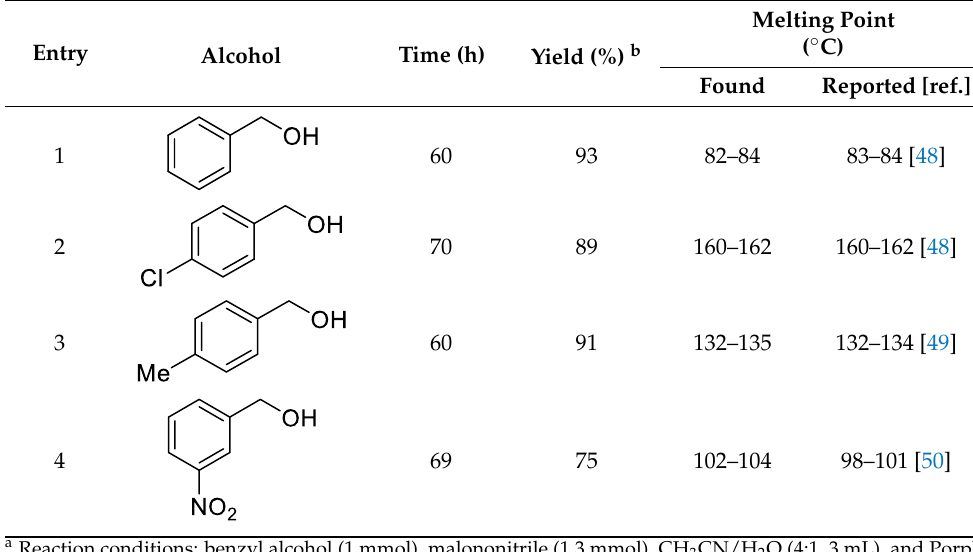
Table 2. Scope investigations for the one-pot tandem light-assisted synthesis of α , β -unsaturated nitriles using Porph-UOZ-COF as multifunctional catalyst a . Entry Alcohol Time (h) Yield (%) b